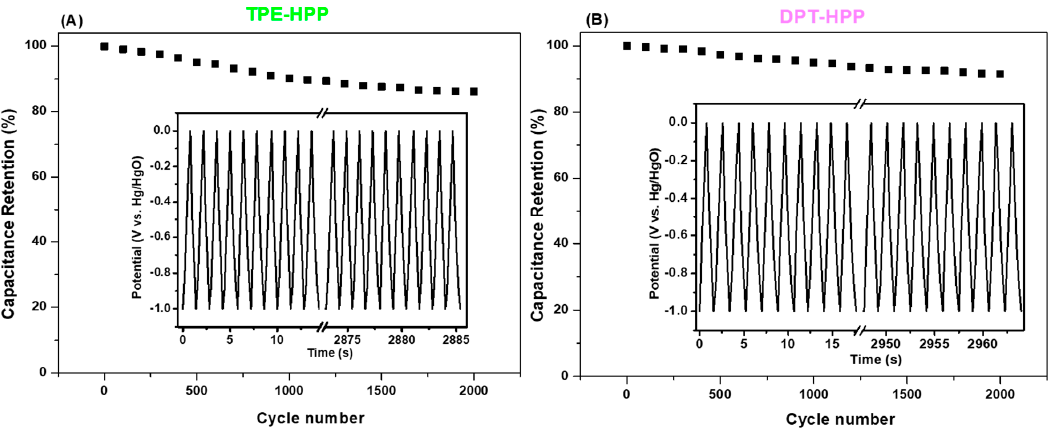
Figure 12. Cycling stability performance of ( A ) TPE-HPP and ( B ) DPT-HPP measured at a current density of 10 A g –1 for 2000 cycles.